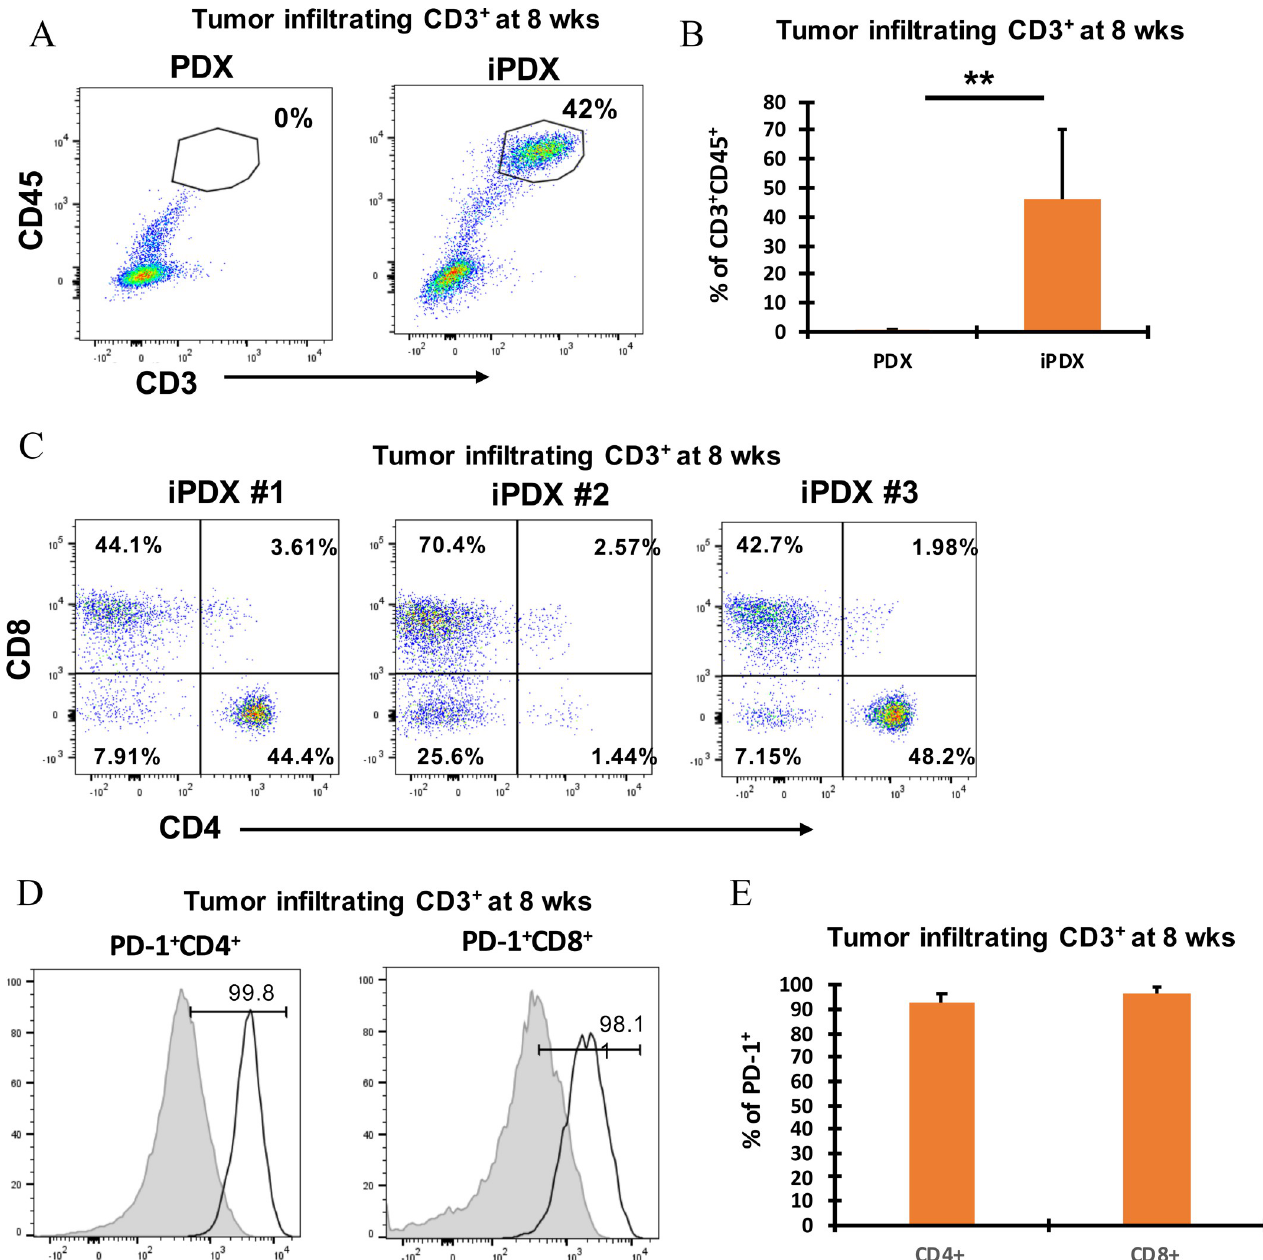
Fig 3. Identification and phenotypic characterization of MCC iPDX tumor derived human CD3+ T cells. (A) Representative flow cytometry dot plots showing CD3+CD45+ tumor infiltrating lymphocytes (TILs) (top left); (B) Bar graph of average values (top right). Data from samples collected at 8 weeks. (C) CD4+ and CD8+ TILs from 3 individual MCC iPDX mouse tumors (bottom panel). Data from samples collected at 8 weeks. (D) PD-1+CD4+ TILs (left) and PD-1+CD8+ TILs (middle) from a representative MCC iPDX mouse tumor. T lymphocytes from non-cancer human donor PB obtained from phlebotomy lab (grey histogram, left) and TILs from iPDX tumor (empty histogram, right). (E) Bar graph showing average percentage of PD-1+CD4+ and CD8+ T lymphocytes from 3 individual MCC iPDX mouse tumors. Data from samples collected at 8 weeks. Values represent mean of three animals per group ± SD. �� p <